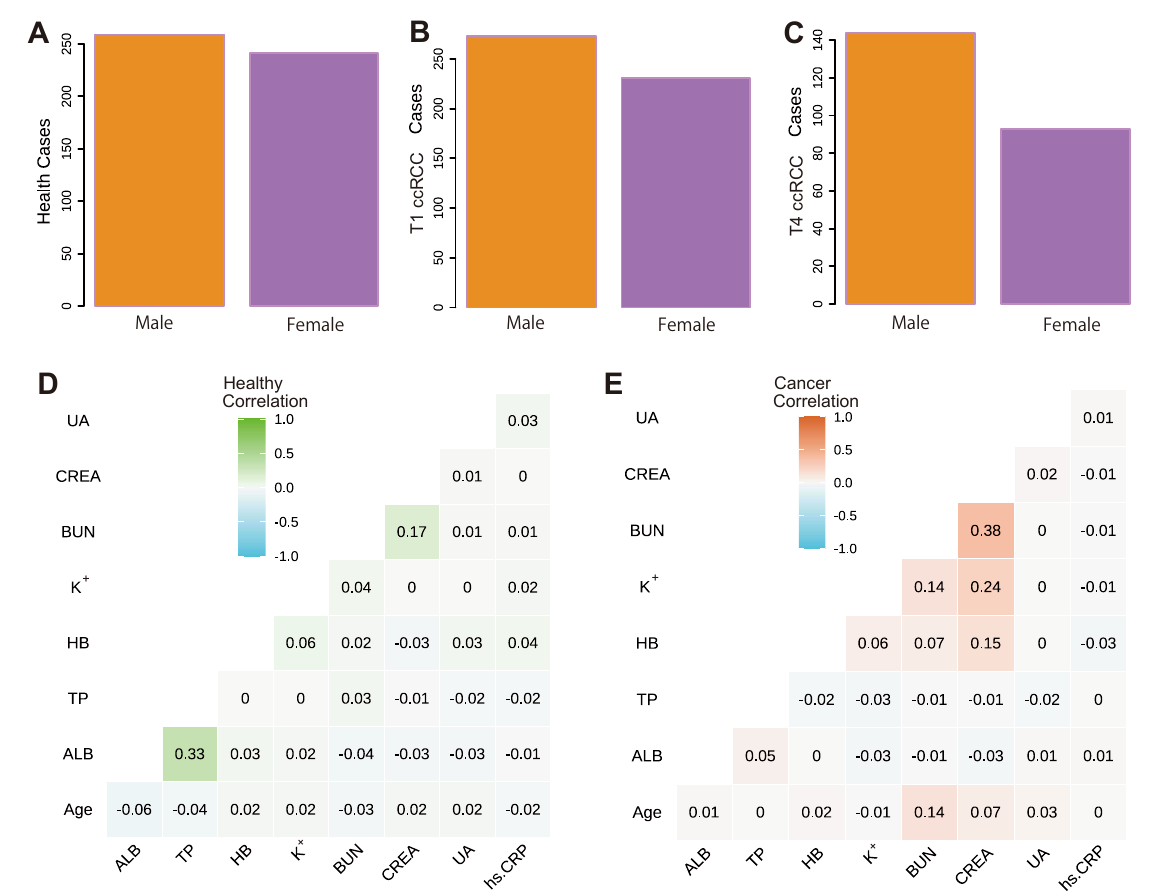
Figure 2. The distribution of male and female population and correlation analysis between blood indicators of healthy and cancer samples. ( A ) The distribution of men and women in the healthy population. ( B ) The distribution of men and women in the early-stage cancer population. ( C ) The male and female distribution in the advanced cancer population. ( D ) The correlation analysis results between the healthy population’s blood indicators. ( E ) The results of correlation analysis between blood indicators of the early-stage cancer